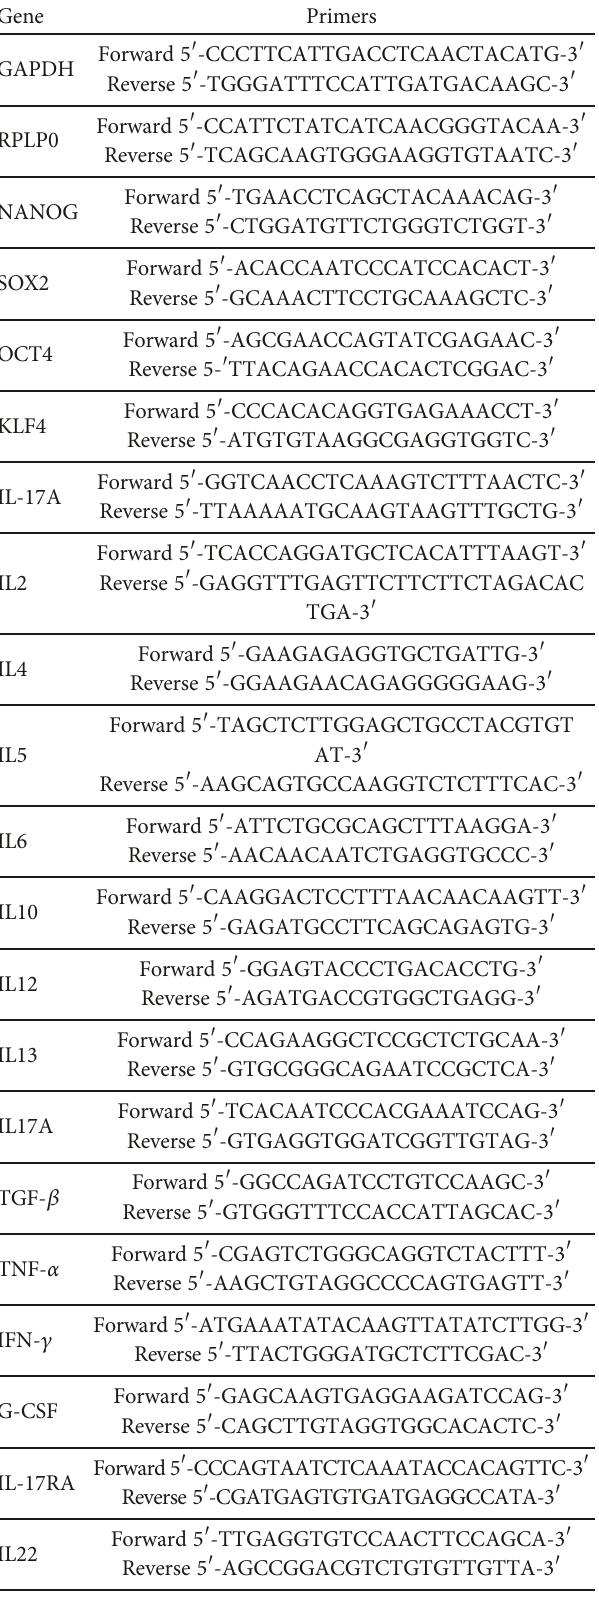
Table 1: Primer sequences. Table 1: